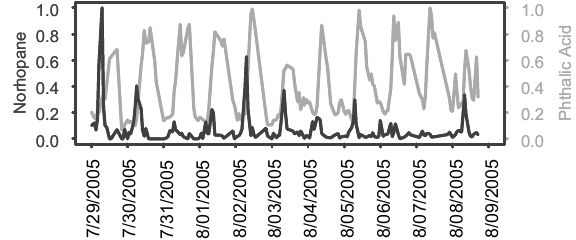
Fig. 4. Comparison of a POA species (28-nor-17 β (H)-hopane, in black) and a SOA species (phthalic acid, in grey) as mea- sured by TAG during SOAR-1. Normalized abundance timelines are shown since maximum phthalic acid mass concentrations are much higher than 28-nor-17 β (H)-hopane concentrations. Only the particle-phase fraction is shown for each